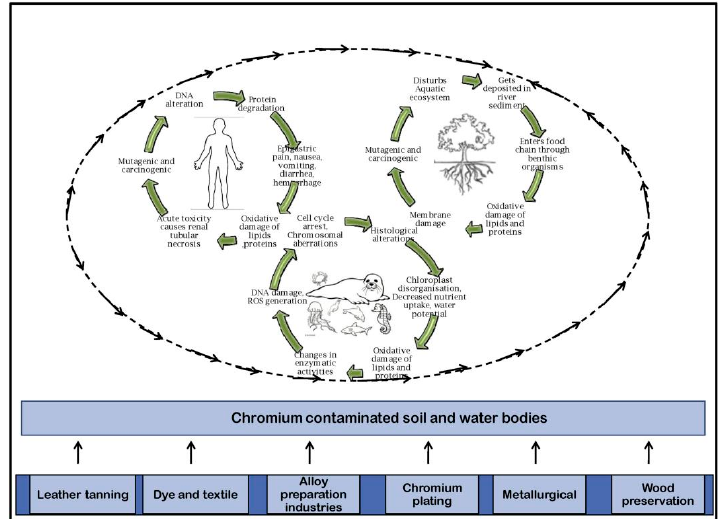
Figure 4. Chromium toxic effects on the ecosystem [92].